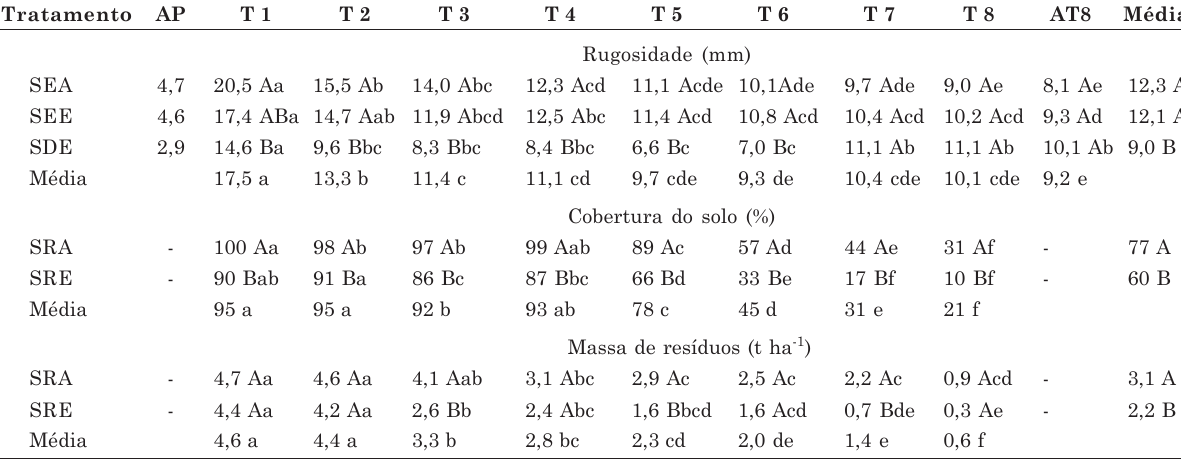
Quadro 5. Valores de rugosidade ao acaso da superfície do solo (RR) de cada tratamento antes do preparo do